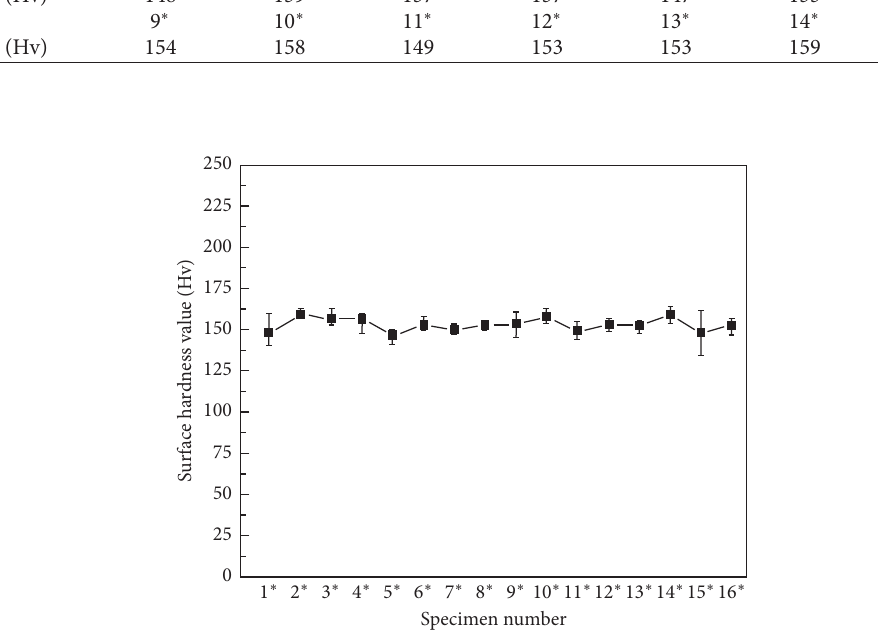
Figure 2: Standard deviation graph of surface